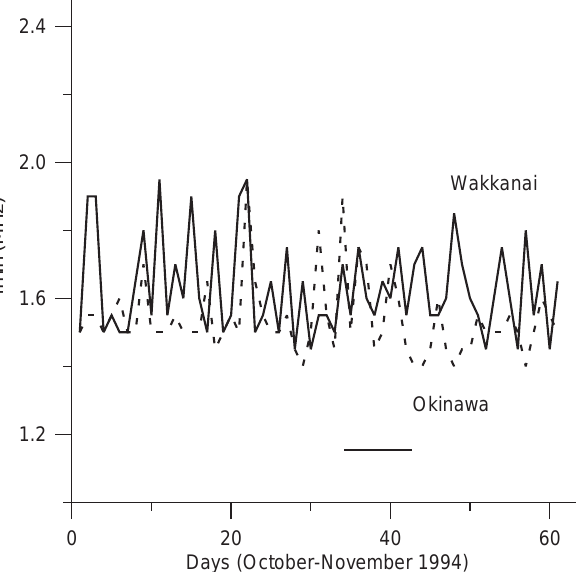
Fig. 1. Development of the North Pole stratospheric temperature at 10 hPa during October–November, 1994 (days 1–61). Short horizontal line indicates interval of the CRISTA/MAHRSI experiment